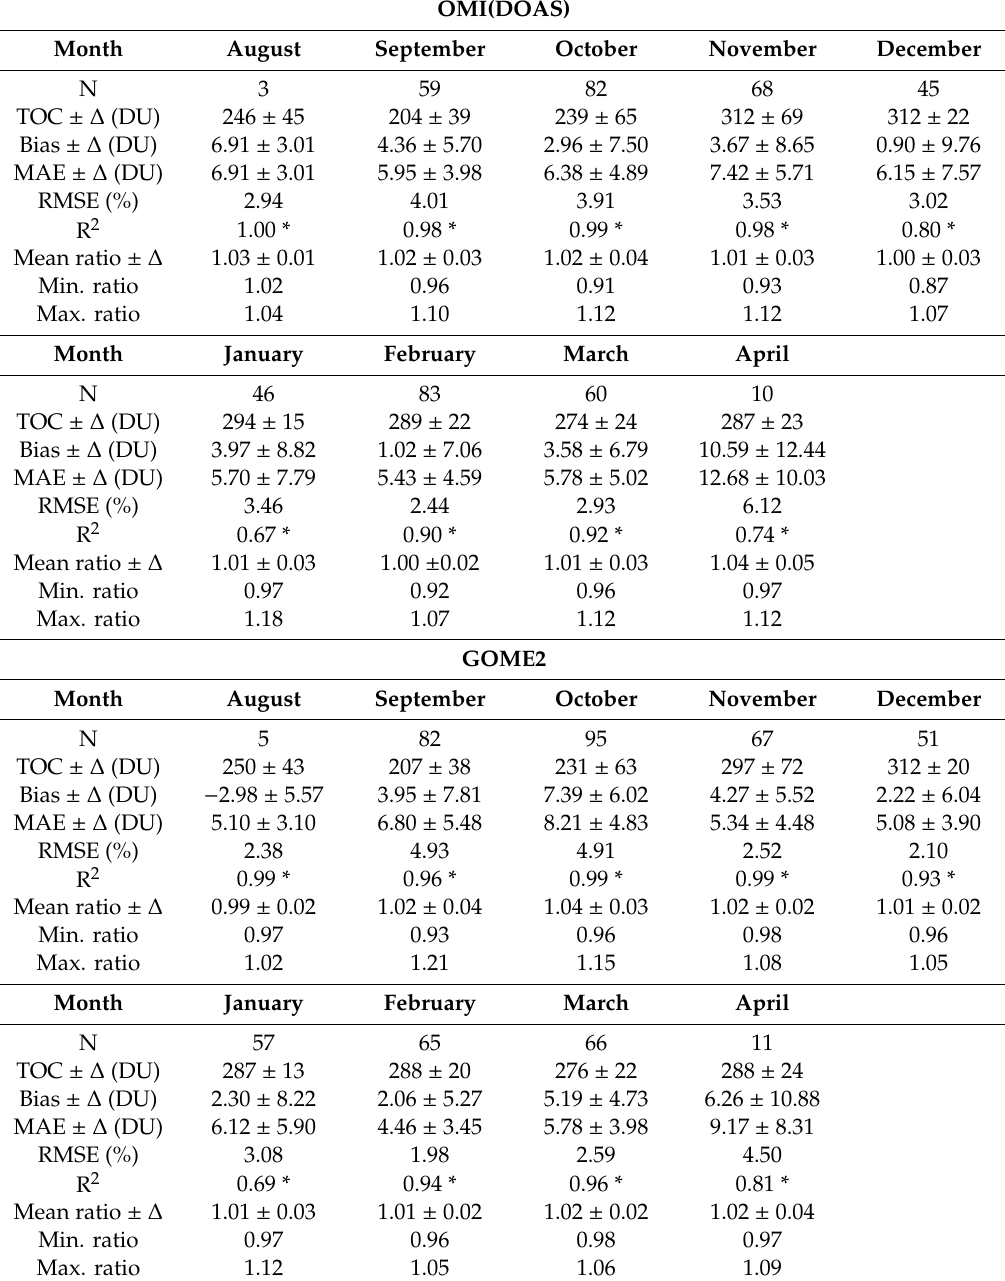
Table A5. Monthly statistics derived for individual data sources (asterisks indicate statistically significant ( α = 0.05)